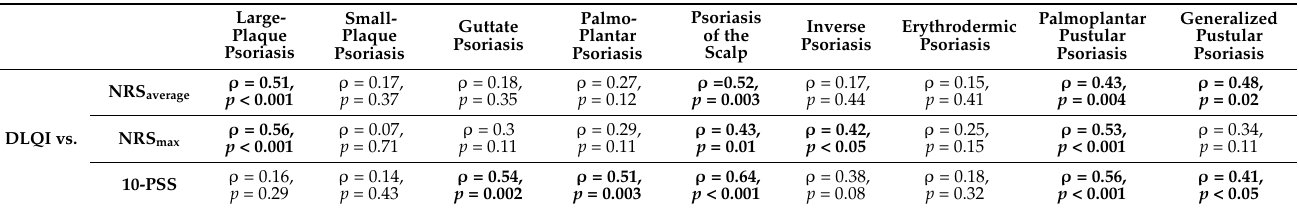
Numerical Rating